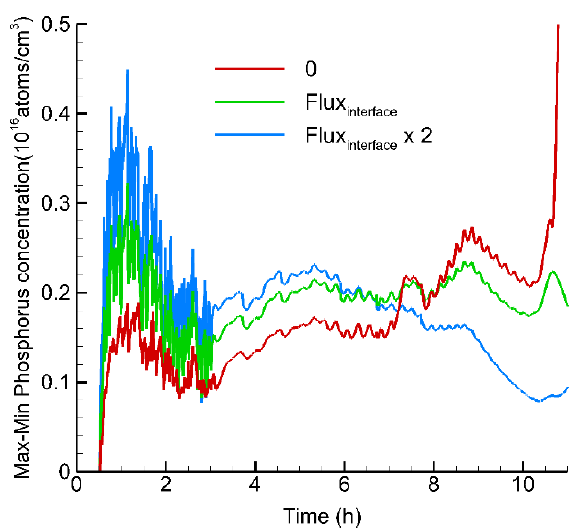
Figure 6. The difference between the maximum and minimum phosphorus concentrations in the melt as a function of time. The phosphorus evaporation flux at the melt surface was (i) 0, (ii) the same as the phosphorus incorporation flux at the melt–crystal interface, and (iii) twice as large as that of case (ii).